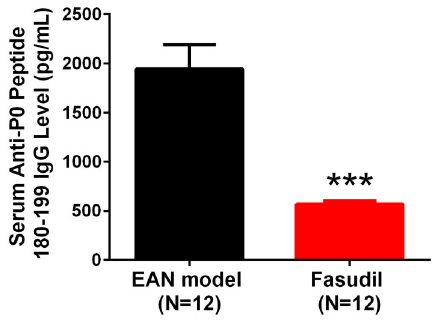
Figure 4. Serum anti-P0 peptide 180 – 199 immunoglobulin G (IgG) level after induction of experimental autoimmune neuritis (EAN). Fasudil decreased serum anti-P0 peptide 180 – 199 IgG level at day 28. Data are reported as mean and SD. ***P o 0.001 ( t